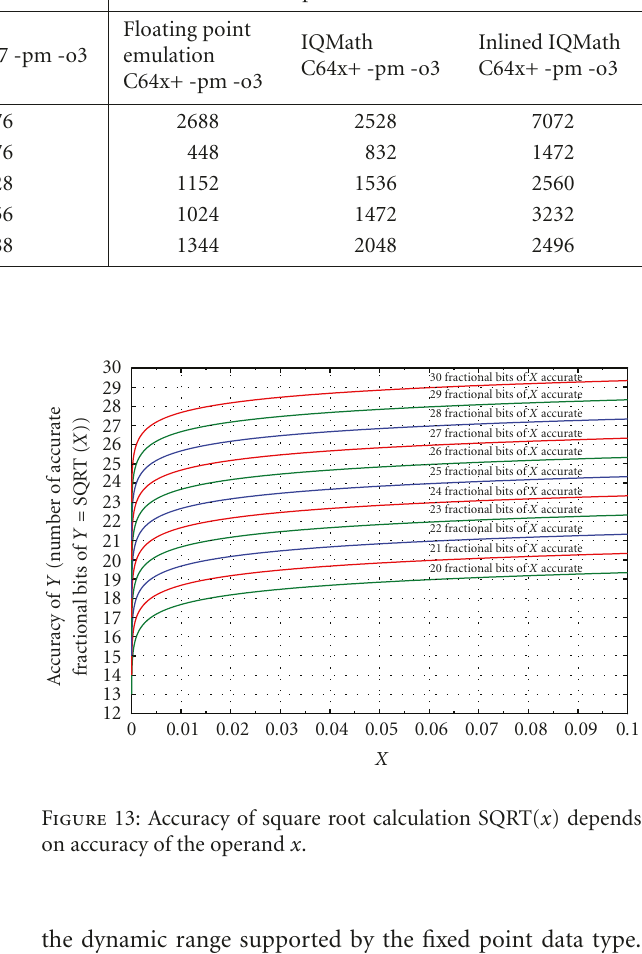
Table 7: Algorithm code size relative to various numerical linear algebra implementations. Algorithm code